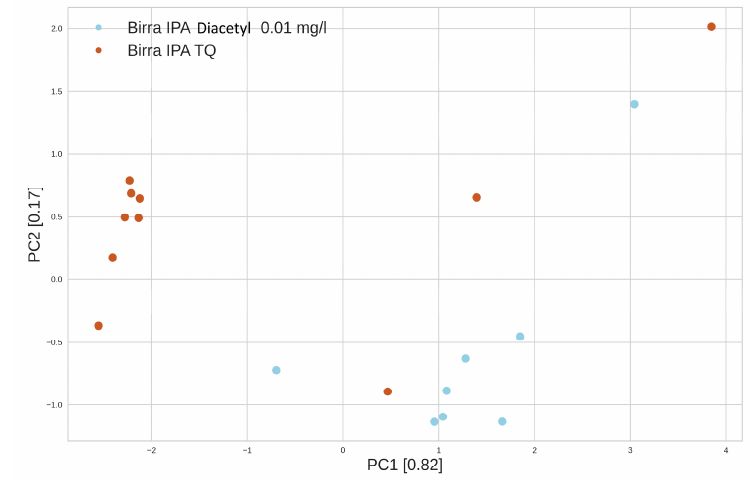
Figure 5. Comparison between two different IPA samples. Brown dots: IPA beer in an unaltered state (US); light blue dots: IPA with 0.01 mg/L of diacetyl. All outliers, as shown in Figure 6, were